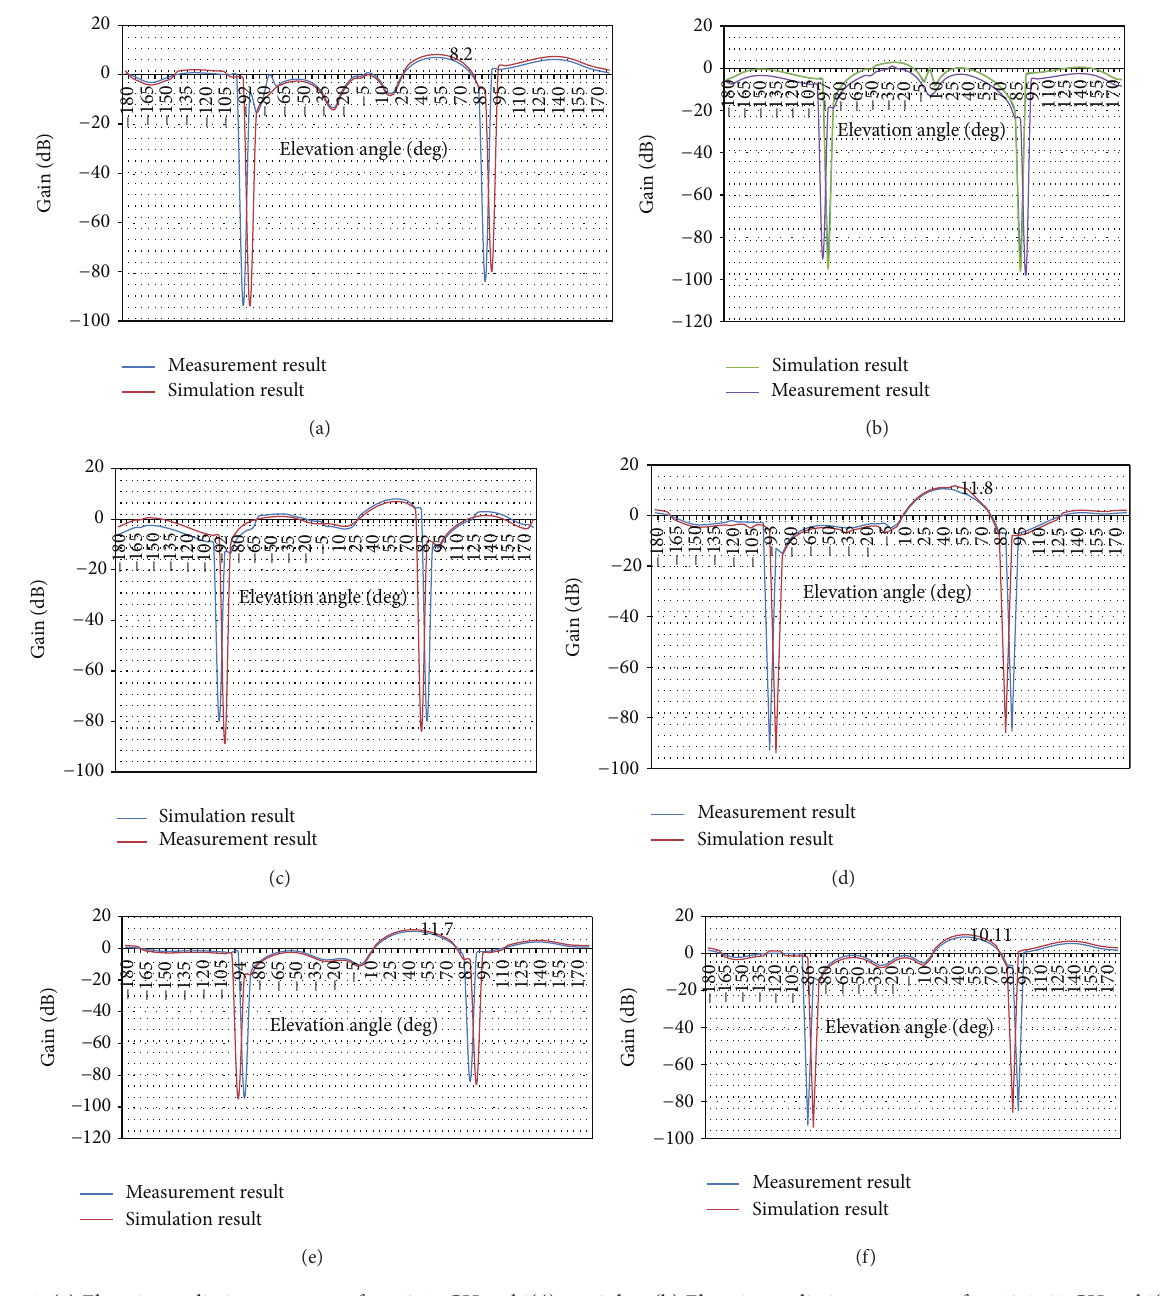
Figure 9: (a) Elevation radiation pattern at 𝑓 = 18.17 GHz, phi (𝜙) = 70 deg. (b) Elevation radiation pattern at 𝑓 = 10.4592 GHz, phi (𝜙) = 50 deg. (c) Elevation radiation pattern at 𝑓 = 12.1122 GHz, phi (𝜙) = 50 deg. (d) Elevation radiation pattern at 𝑓 = 15.97 GHz, phi (𝜙) = 50 deg. (e) Elevation radiation pattern at 𝑓 = 16.2449 GHz, phi (𝜙) = 60 deg. (f) Elevation radiation pattern at 𝑓 = 17.0714 GHz, phi (𝜙) = 70 deg.